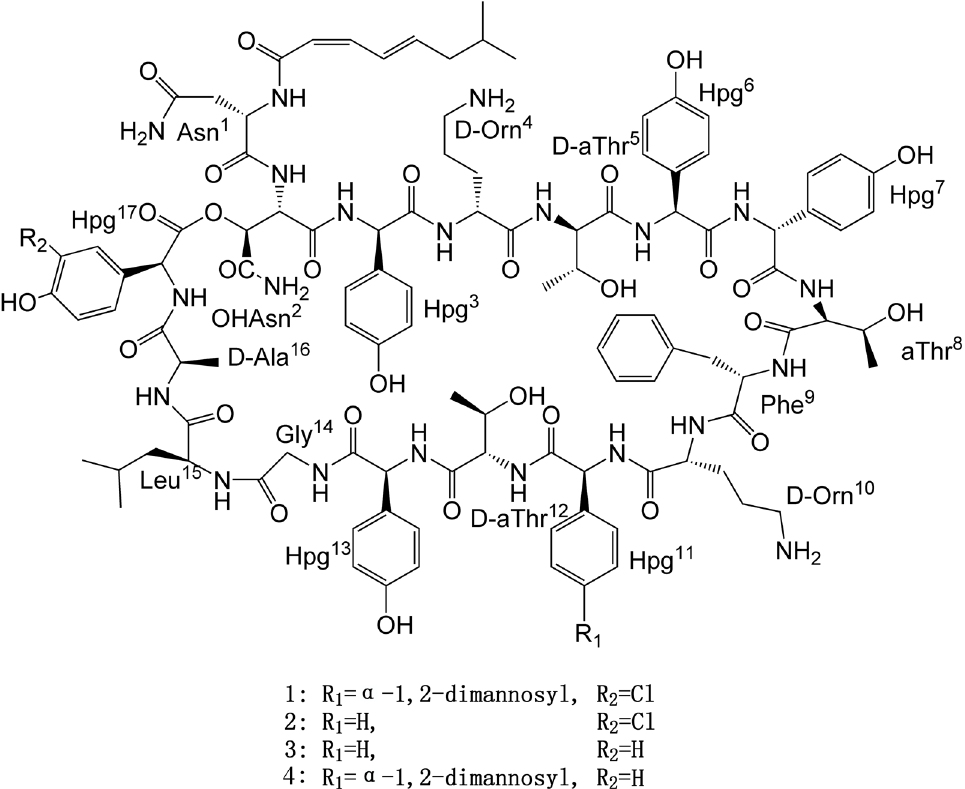
Fig 1. Structure of ramoplanin and its